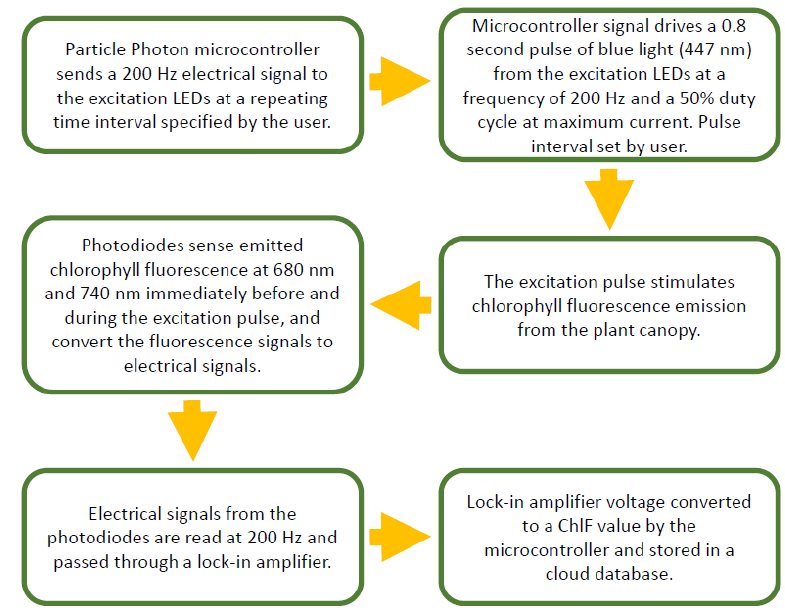
Figure 2. ChlF detection proceeded via six basic